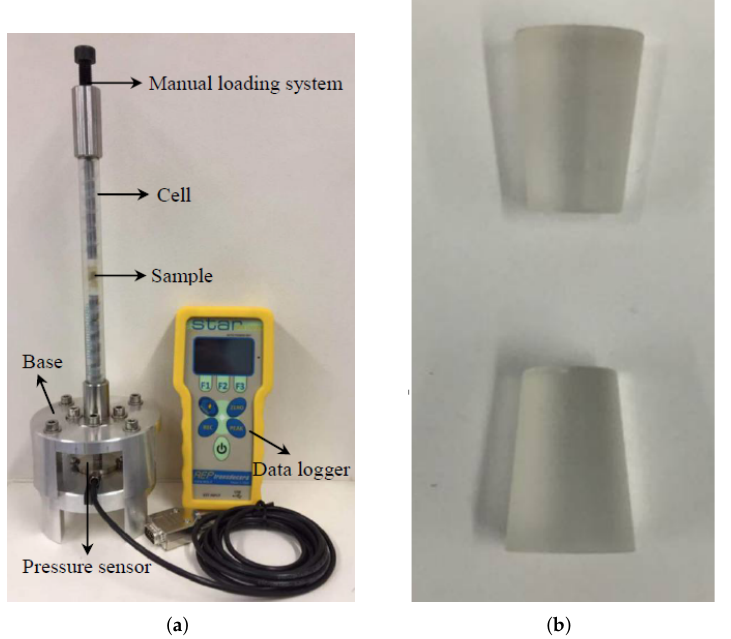
Figure 3. ( a ) Overall view of in situ creep test system; ( b ) translucent polycarbonate pistons